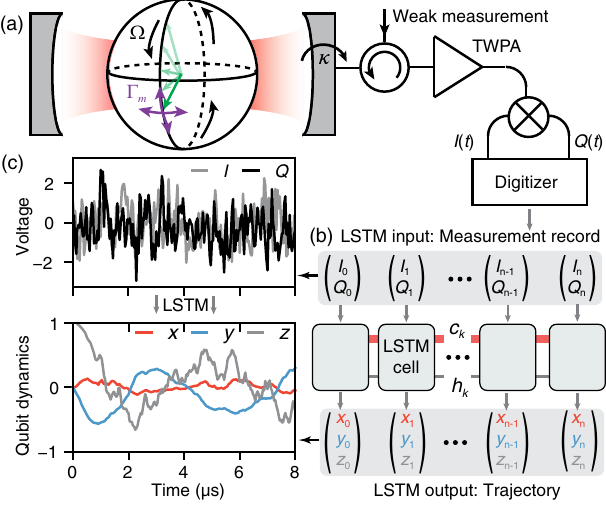
FIG. 1. Monitoring fast qubit dynamics using an LSTM artificial neural network. (a) During weak measurement of a strongly driven qubit, the qubit state (green arrow) evolves due to a coherent Rabi drive (black, rate Ω ) and backaction from both quadratures of a heterodyne measurement (purple arrows). If Ω exceeds the resonator relaxation rate κ = 2 , memory effects such as delay and qubit-resonator correlations can no longer be ignored when reconstructing trajectories. (b) The LSTM learns the stochastic, dissipative qubit dynamics, mapping elements of each noisy voltage record ( I , Q ) to a qubit Bloch vector trajectory ( x , y , z ). The cell state c and hidden state h can encode long- k k term correlations in the measurement record. (c) Sample record with corresponding qubit trajectory output by the trained